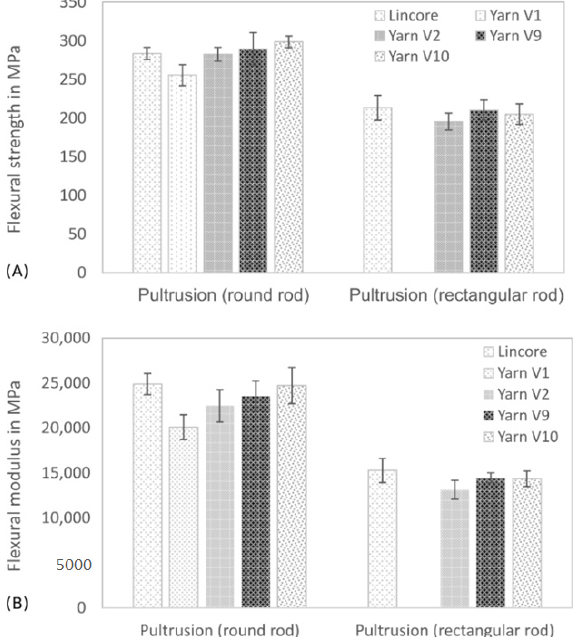
Figure 7. Flexural strength ( A ) and flexural modulus ( B ) of pultruded round and rectangular rods (fibre volume fraction of round rods ~ 40% and of rectangular rods ~ 30%). Results are shown as mean values with standard deviation as error bars.